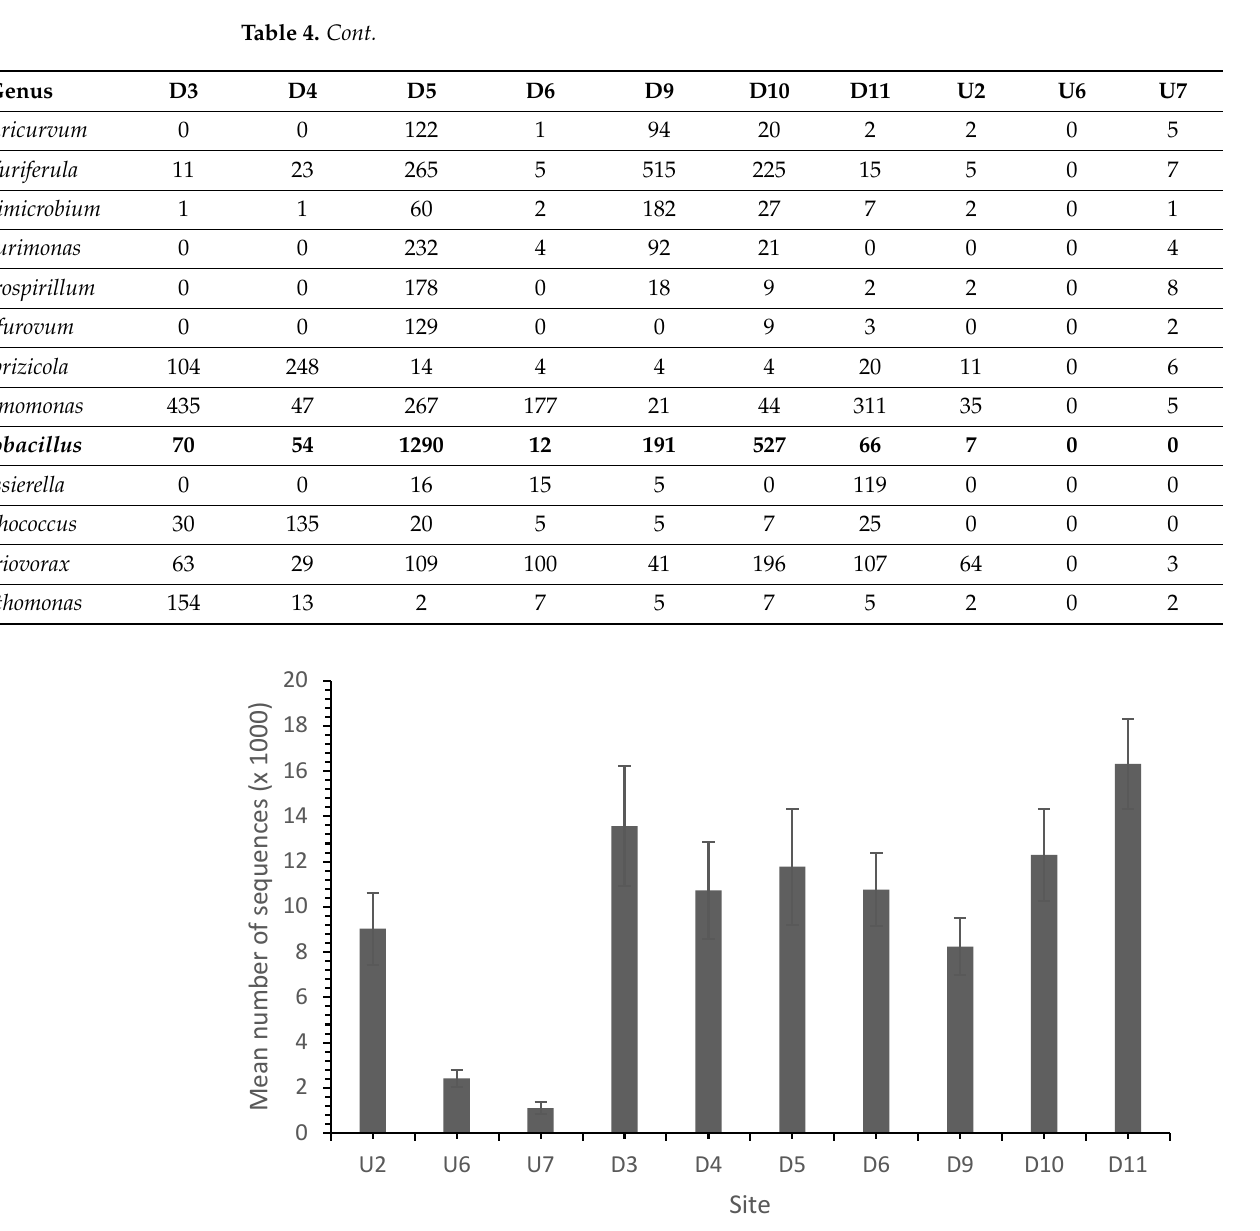
Figure 4. Total sequence number by site. AMD reduced the total sequence number, which recovered as the distance from the landfill site increased.